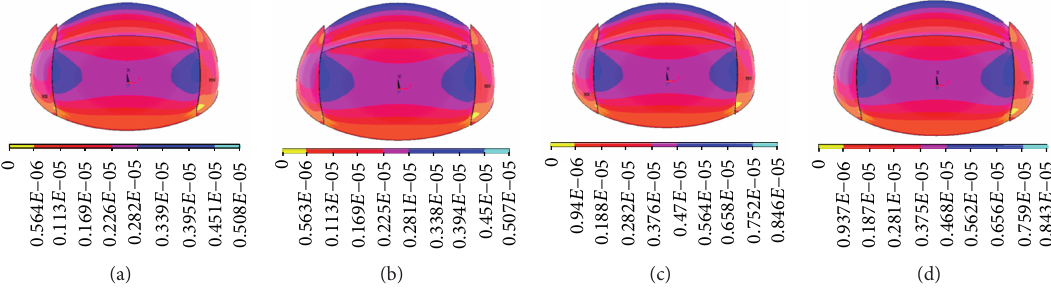
Figure 12: Strain graph. (a) Without hypothermia treatment when ICP is 3.0 kPa, (b) with hypothermia treatment when the ICP is 3.0kPa, (c) without hypothermia treatment when the ICP is 5.0 kPa, and (d) with hypothermia treatment when the ICP is 5.0 kPa.